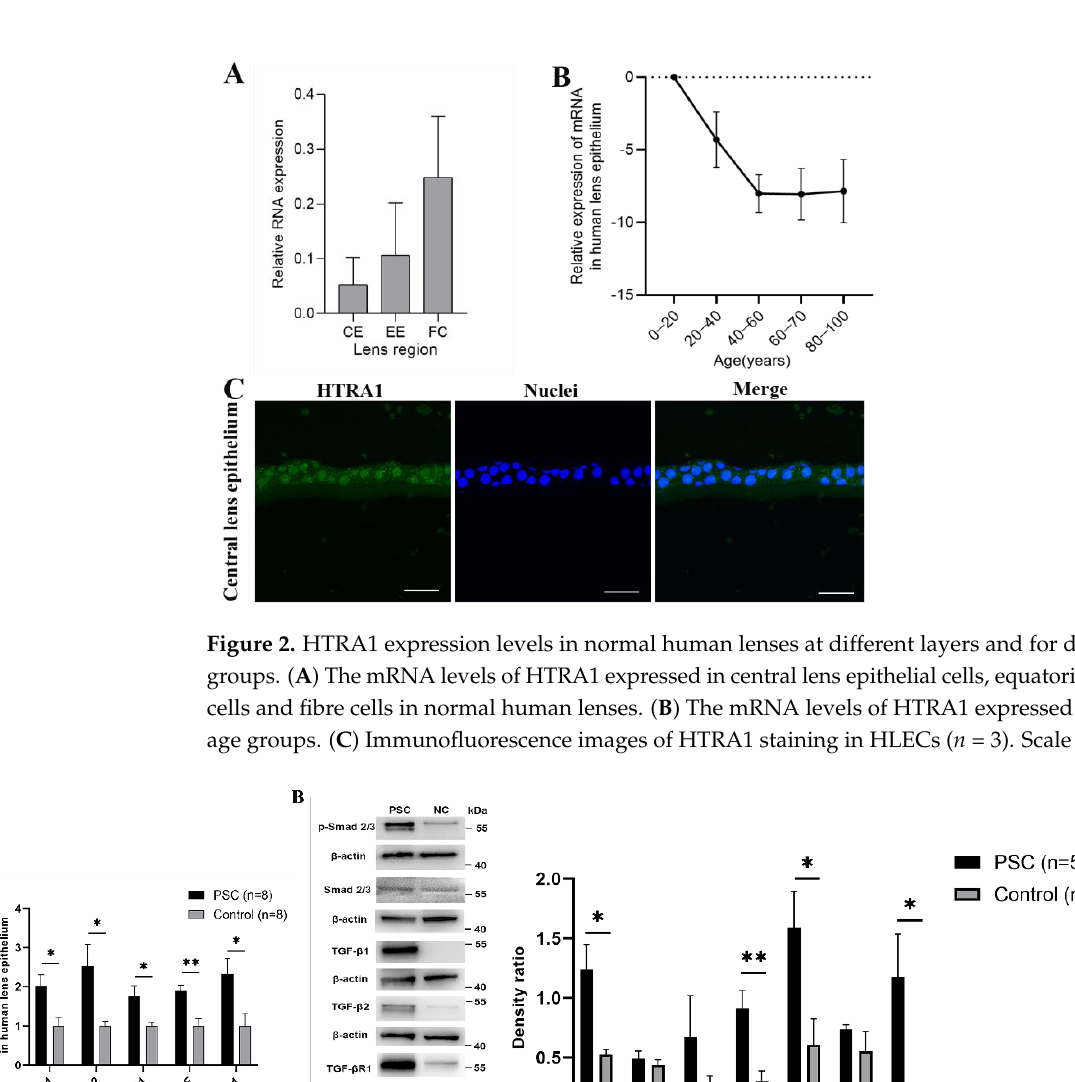
Figure 2. HTRA1 expression levels in normal human lenses at different layers and for different age groups. ( A ) The mRNA levels of HTRA1 expressed in central lens epithelial cells, equatorial epithe- lial cells and fibre cells in normal human lenses. ( B ) The mRNA levels of HTRA1 expressed in dif- ferent age groups. ( C ) Immunofluorescence images of HTRA1 staining in HLECs ( n = 3). Scale bar: 10 μm.